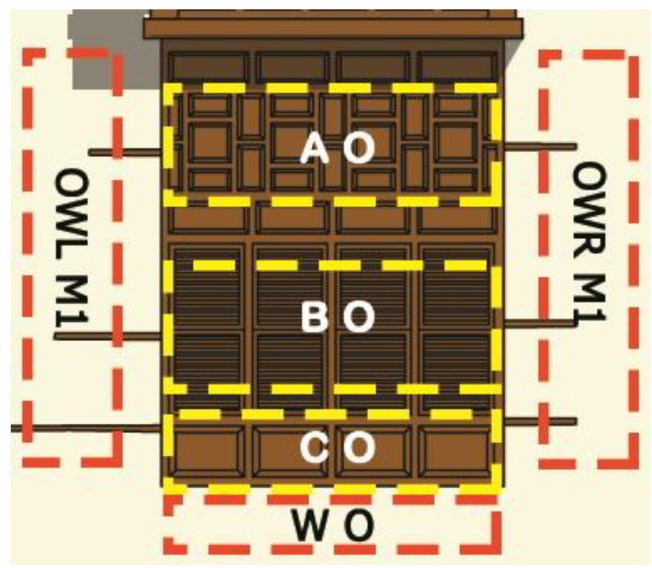
Figure 19. Measurement zones and abbreviated on the Mash1 from outside.